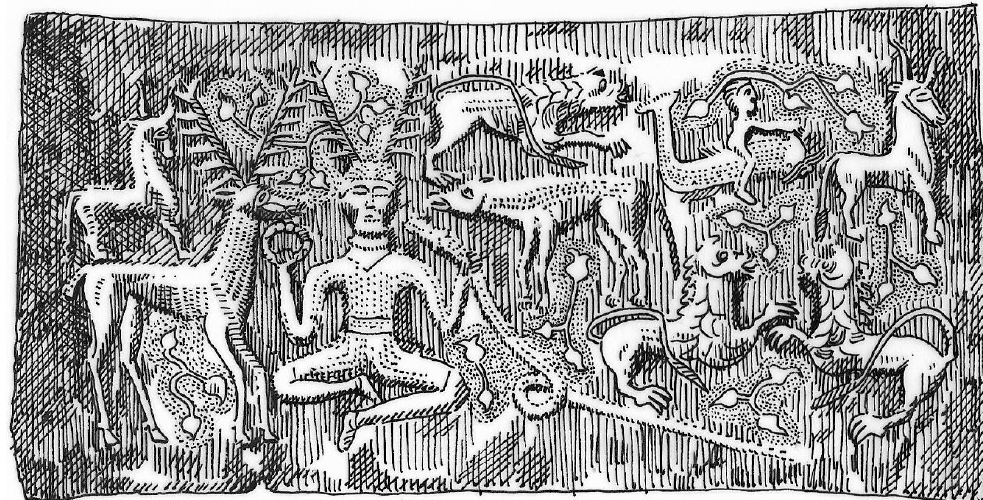
Figure 5. Detail of inner plate depicting an antlered ‘human’ figure, from the late Iron Age silver cauldron from Gundestrup, Jutland, Denmark. © Paul Jenkins.